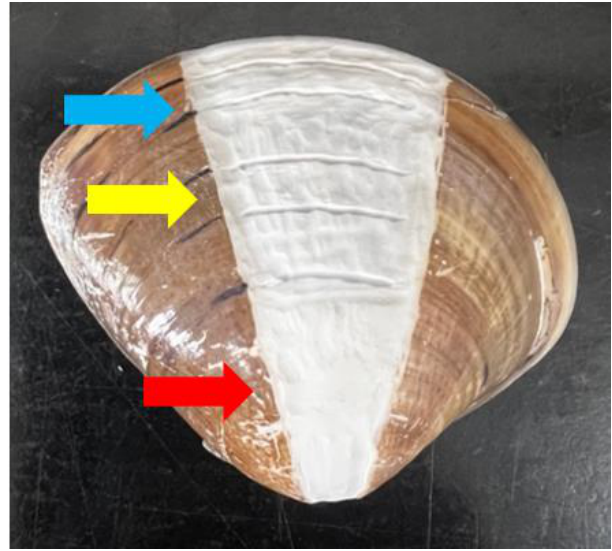
Figure 2. The shell sample of M. meretrix after grinding for removal of the surface to reduce organic matter. The area in the red arrow was the inner site; the yellow arrow was referred to as the middle site; and the blue arrow was mentioned as the outer site.